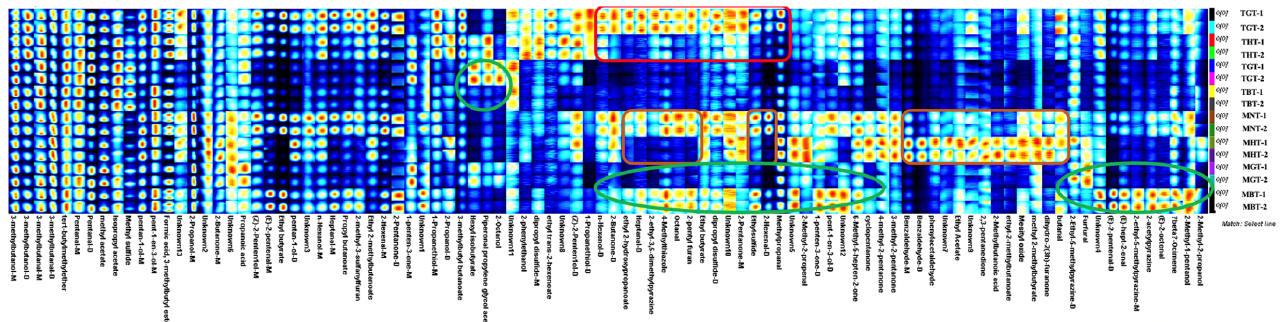
Figure 2. PCA of volatile compounds of eight types of lotus ‐ leaf tea detected via HS ‐ GC ‐ IMS. TNT, tender naturally ‐ dried lotus ‐ leaf tea; THT, tender hot air ‐ dried lotus ‐ leaf tea; TGT, tender green lo ‐ tus ‐ leaf tea; TBT, tender black lotus ‐ leaf tea; MNT, mature naturally ‐ dried lotus ‐ leaf tea; MHT, ma ‐